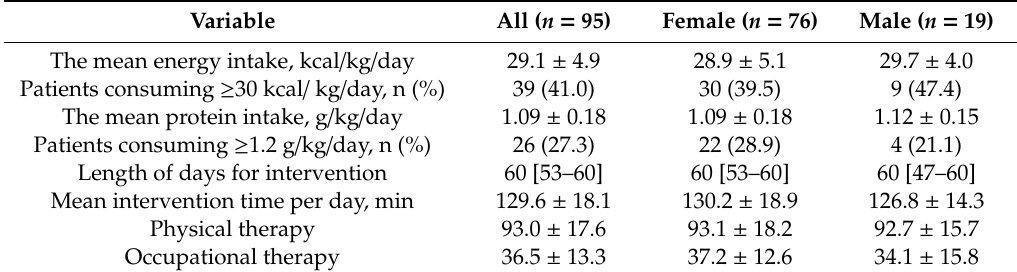
Table 2. Amount of nutrition and intervention during the study.